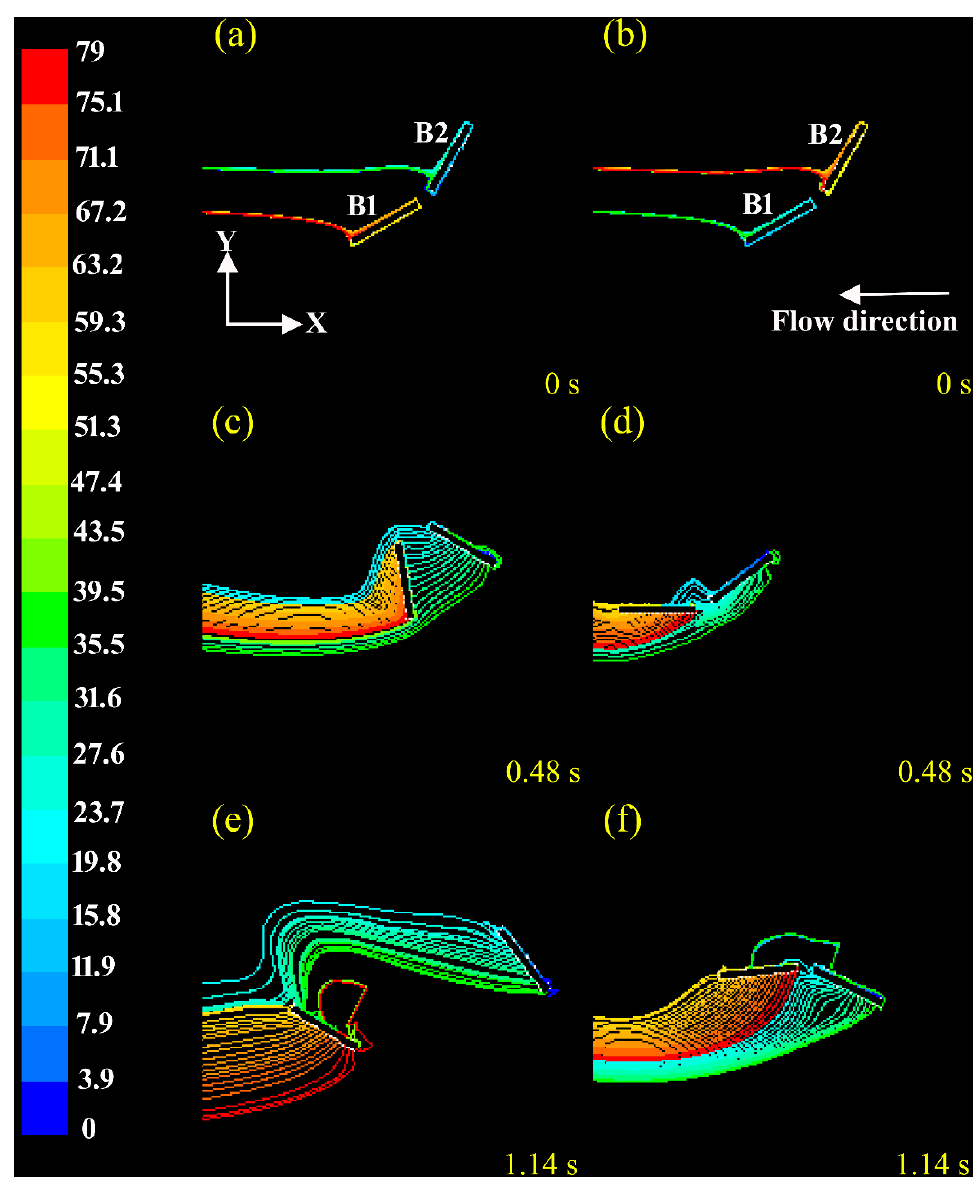
Figure 3. Streamlines of the ( a , c , e ) unconstrained and ( b , d , f ) constrained mechanisms at different simulation times.